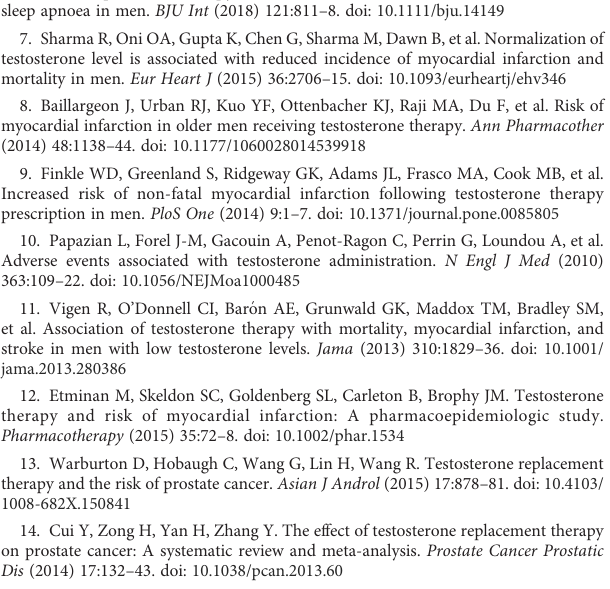
SUPPLEMENTARY FIGURE 2 Assessment levels of proteins related to testosterone synthesis in mice fed with HFD or ND. The mRNA levels of these proteins were assessed by Q-PCR (A) . The protein levels of these proteins were Analyzed by immunoblot (B) . Quantitative analysis for these protein levels (C) . SUPPLEMENTARY FIGURE 3 Assessmentofabilityof Leydigcelltoproducetestosterone inp38LCKOmice andWTmice.Testis morphology wasexamined byHEstaining (B) . ThemRNA levels of proteins and enzymes related to testosterone synthesis were assessed by Q-PCR (C, E) . The protein levels of proteins and enzymes associated with testosterone synthesis were Analyzed by immunoblot (D, F)